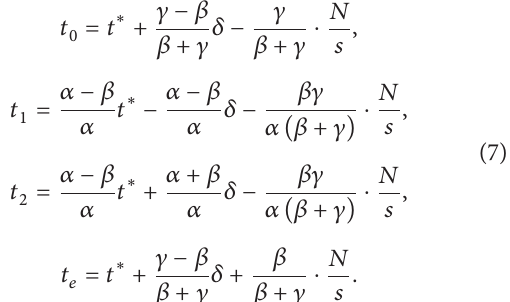
where 𝑡 0 and 𝑡 𝑒 are the earliest time and the latest time with positive departure rate, respectively. And 𝑡 1 and 𝑡 2 are the watershed times for which an individual arrives at work on time.